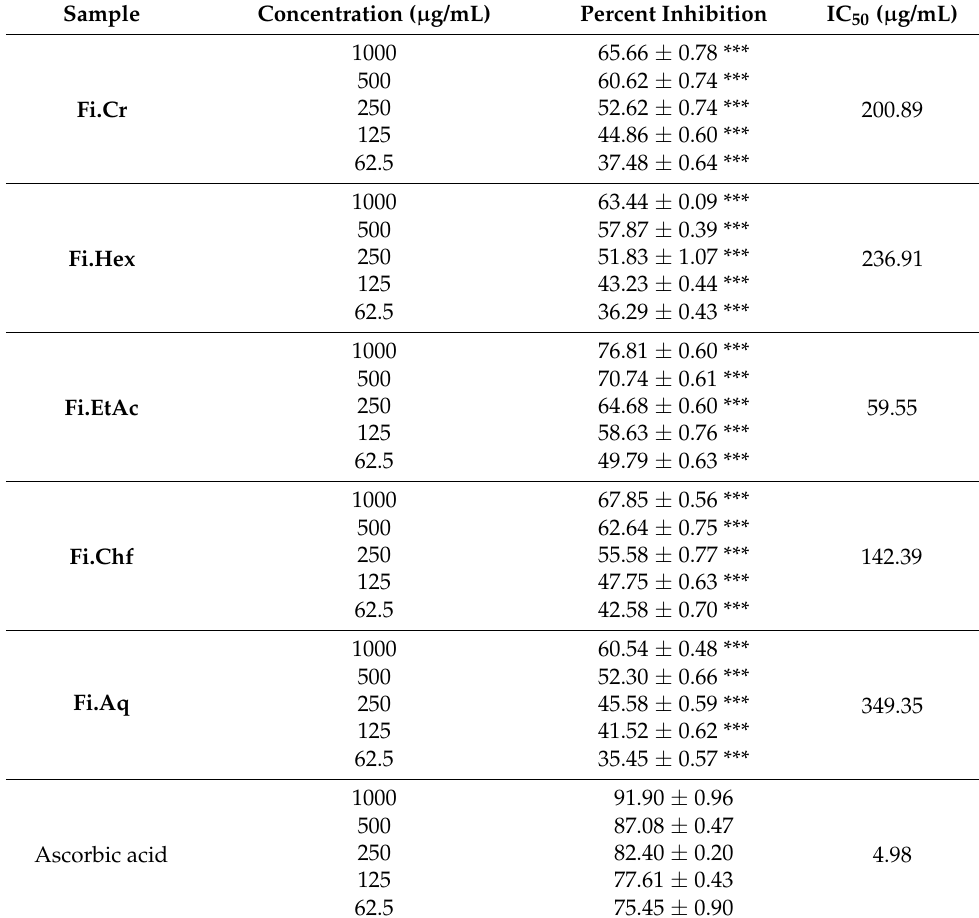
Table 2. DPPH free radicals scavenging results of crude extracts of Fragaria indica